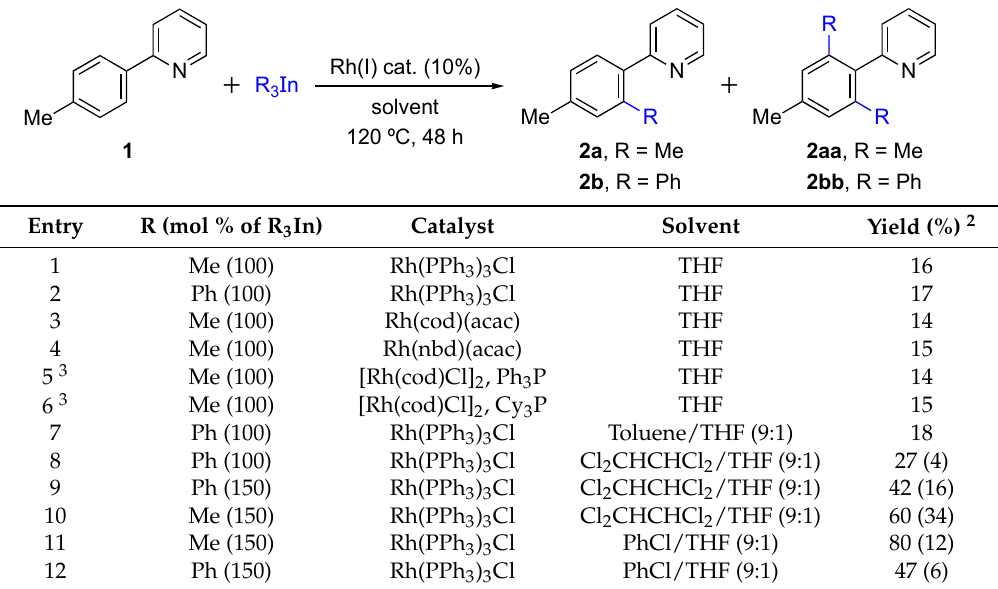
Table 1. Reaction of indium organometallics with 2-( p -tolyl)pyridine under rhodium catalysis 1 .